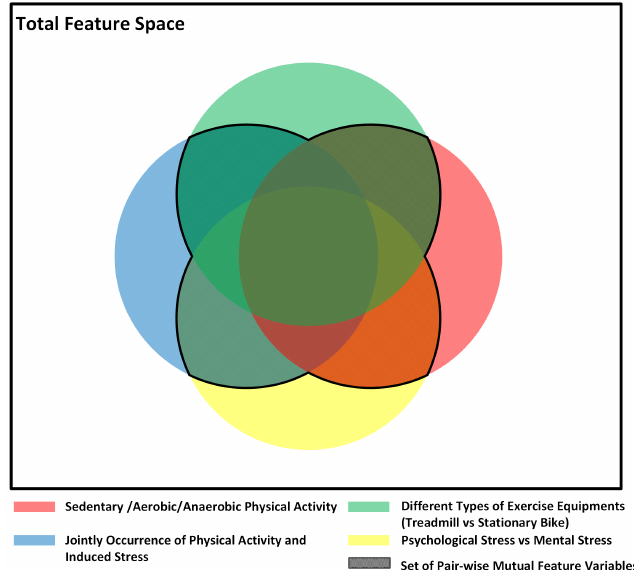
Figure 4. Pairwise aggregation of mutual features (the shaded